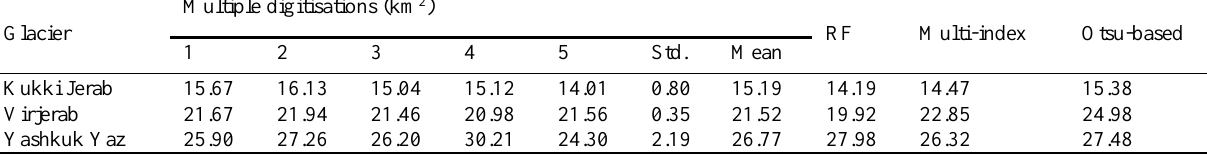
Table 2 Confusion matrix for RF model classification in 2019 (model prediction (top) and validation data (left)) Debris